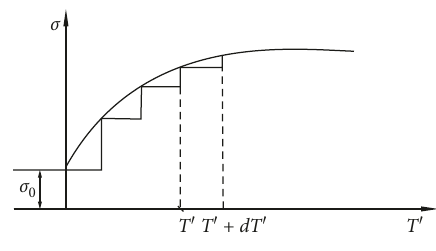
Figure 2: Sketch of the loading curve.